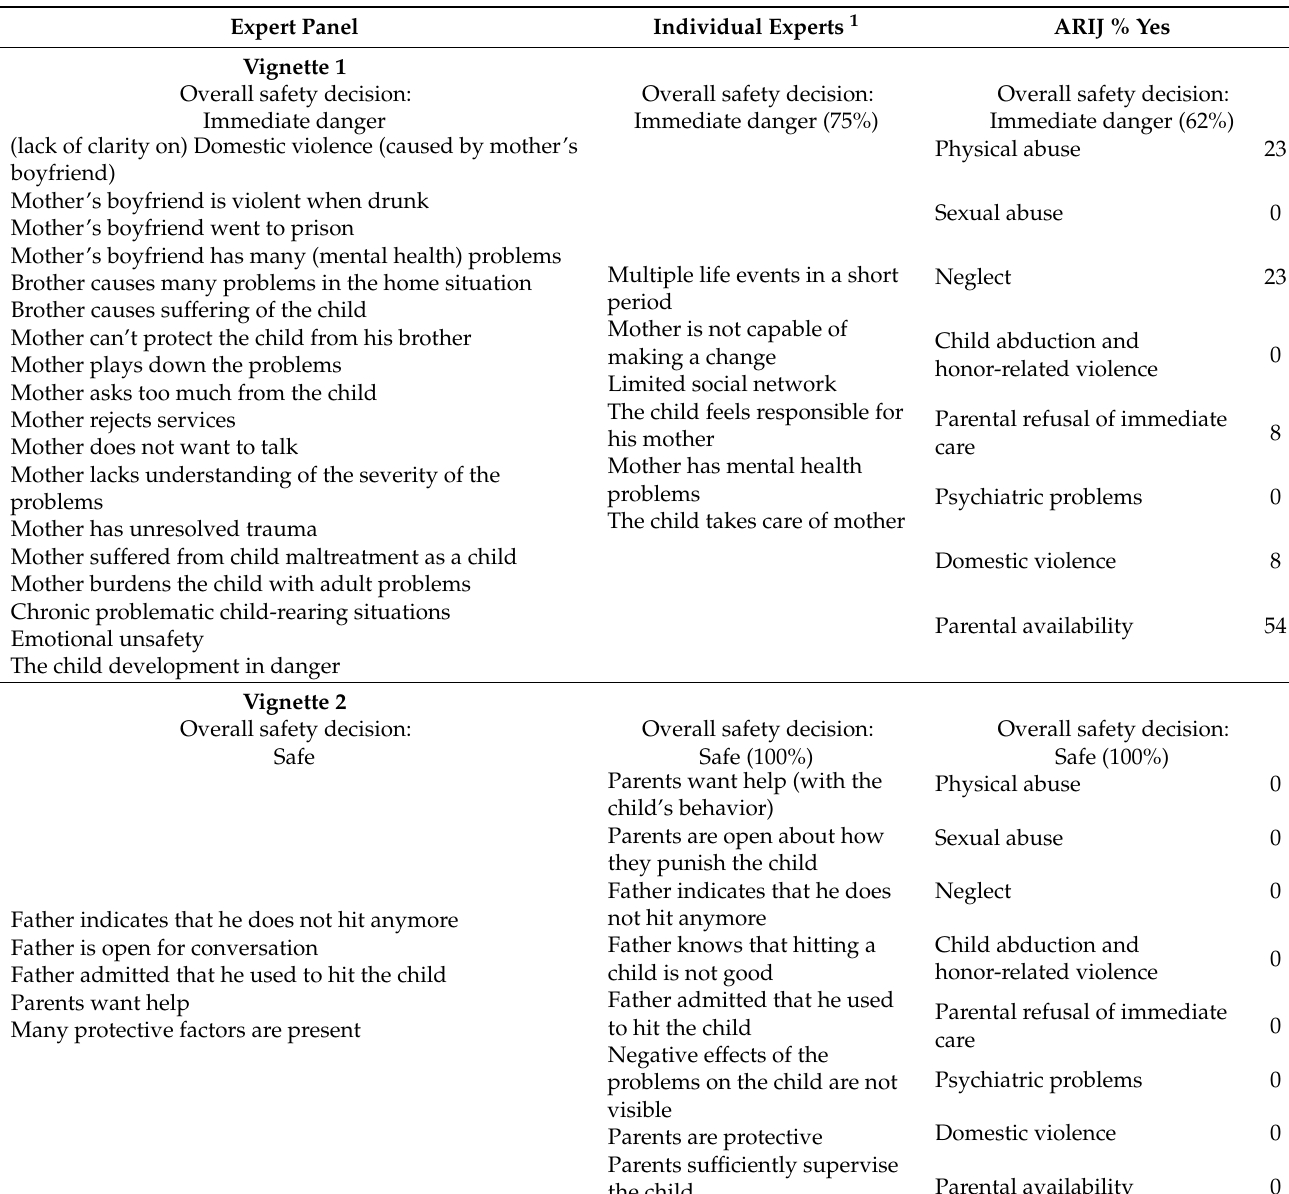
Table A1. Immediate safety threats and reasons the child was identified as safe in the expert panel, individual expert, and ARIJ